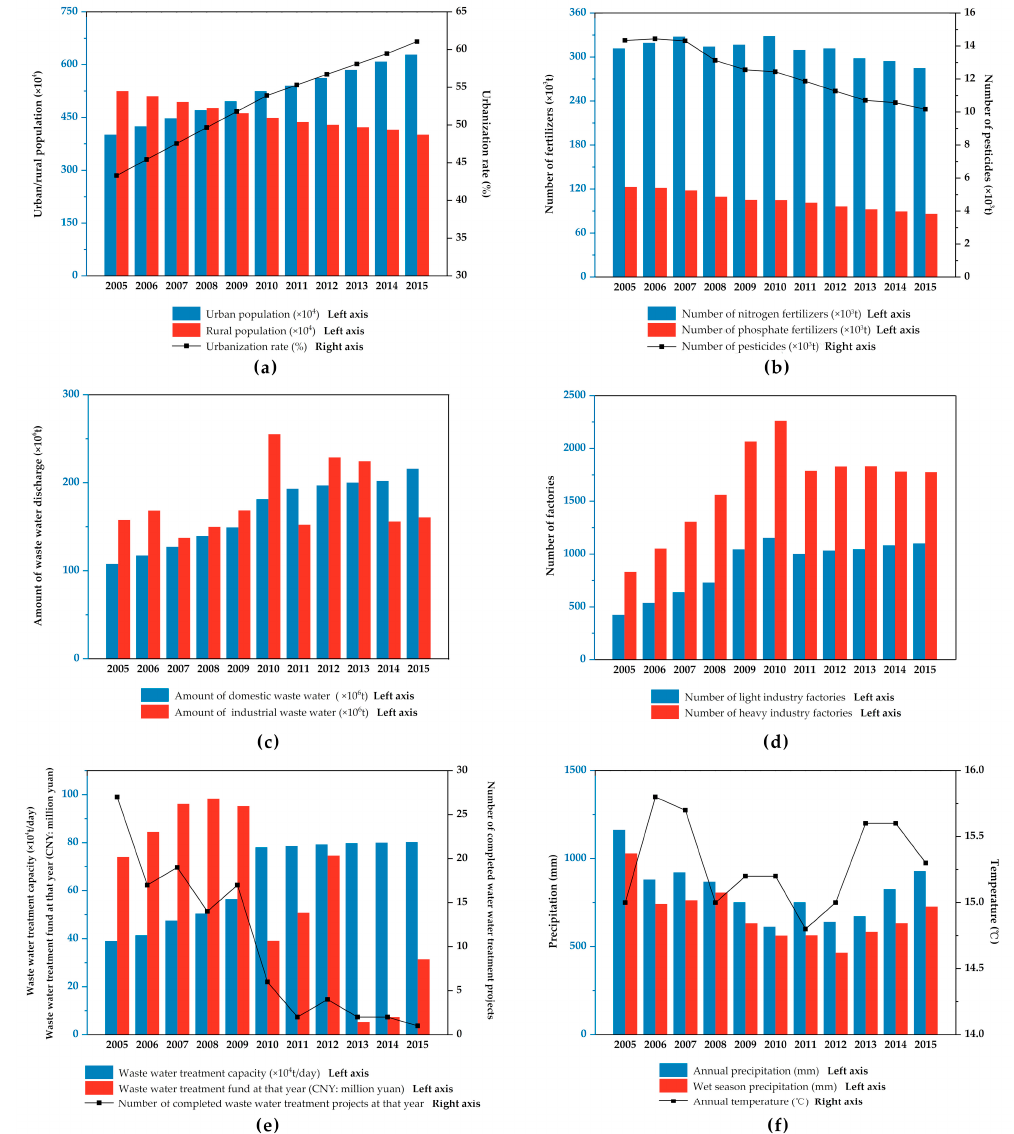
Figure 9. The situation of ( a ) socioeconomic factors, ( b ) chemical fertilizer and pesticide emission, ( c ) waste water discharge, ( d ) number of factories, ( e ) waste water treatment, and ( f ) meteorological factors for Xuzhou from 2005 to 2015.